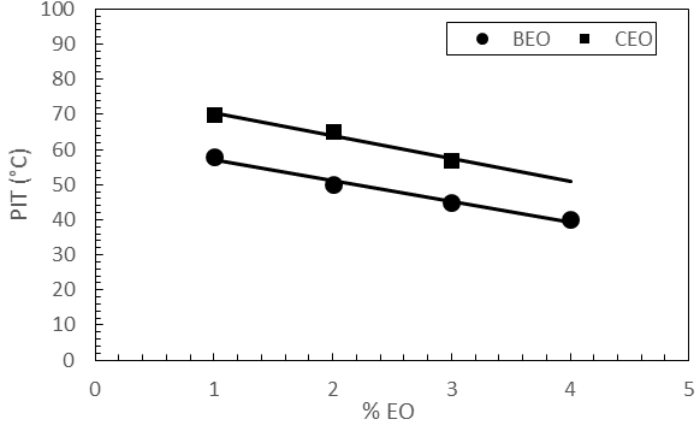
Figure 4. Relationship between the percentages of essential oil (EO) in NLC BEO1–4 and CEO1–3, and the corresponding phase inversion temperature (PIT) values determined during their preparation.